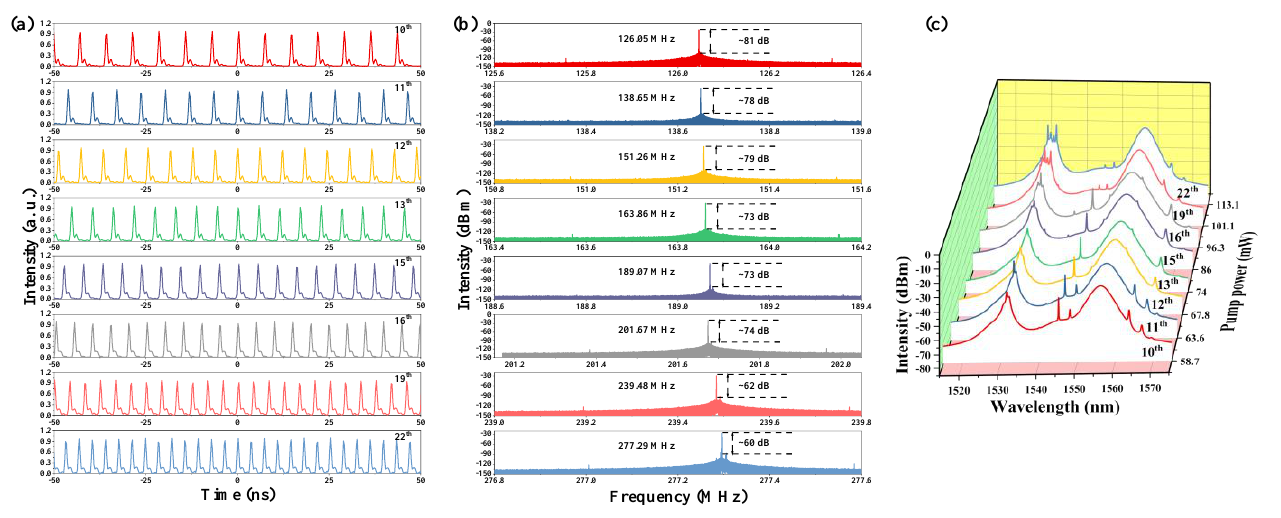
Figure 7. ( a ) Pulse trains from 10th–22nd, ( b ) corresponding RF spectra, ( c ) changing trend of the optical spectra of the harmonic order from 10th–22nd.